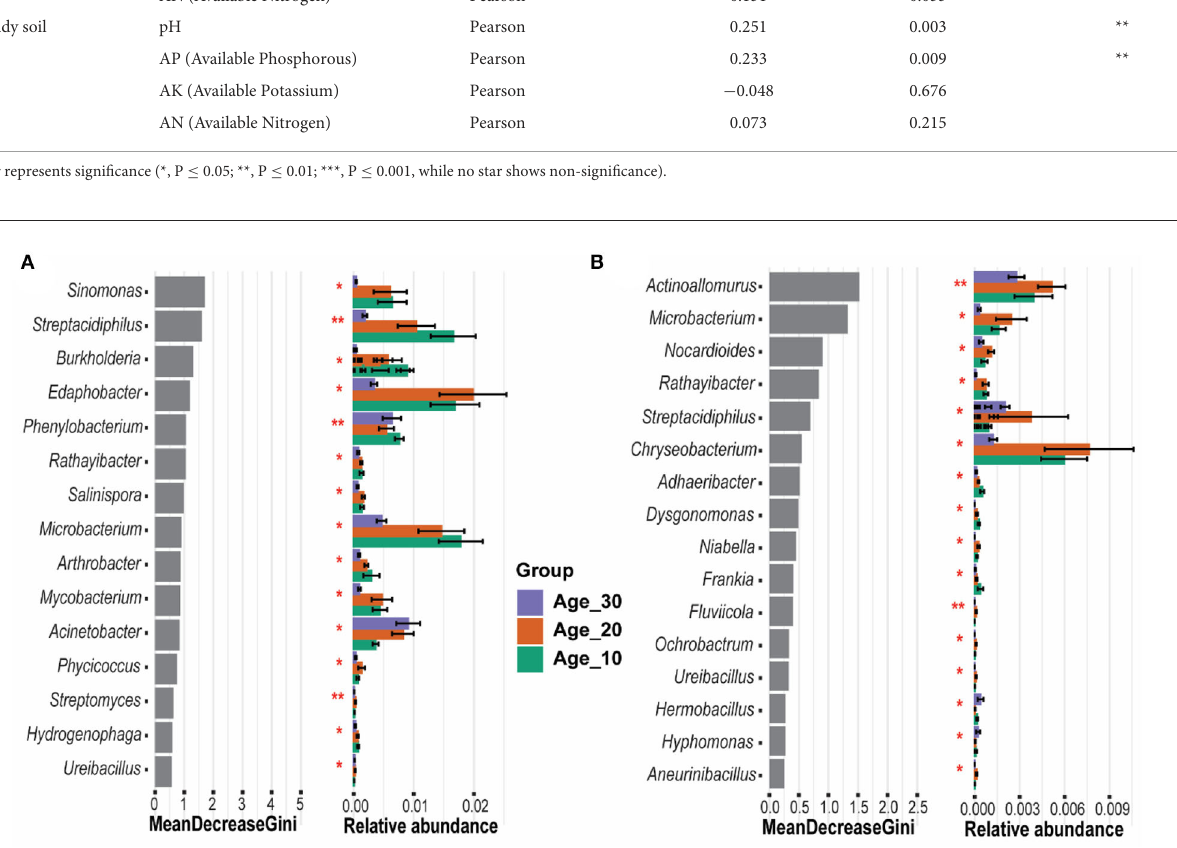
FIGURE6 Random forest classification for evaluation of important genera. Gini index was used to determine the most significant genera, which exhibited the significance of each genus in distinguishing different age groups of (A) red soil and (B) paddy soil. Here, Age_10, Age_20, and Age_30 denote the different pomelo tree ages of 10, 20, and 30 years,